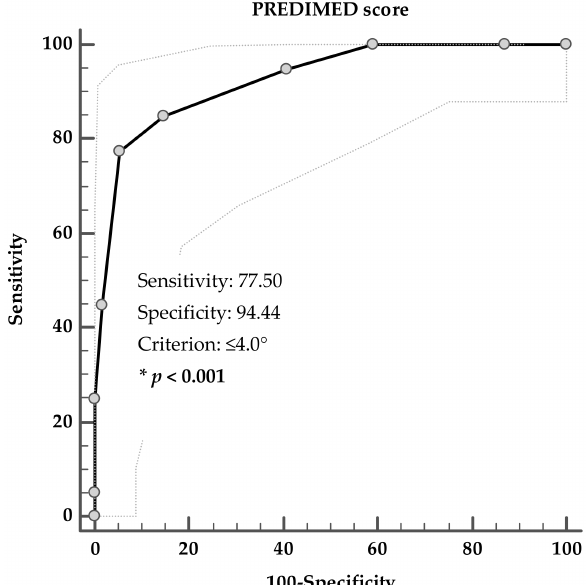
Figure 1. ROC for predictive values of PREDIMED score in detecting the presence of PCOS MUO phenotype. * A p value in bold type denotes a significant difference ( p <